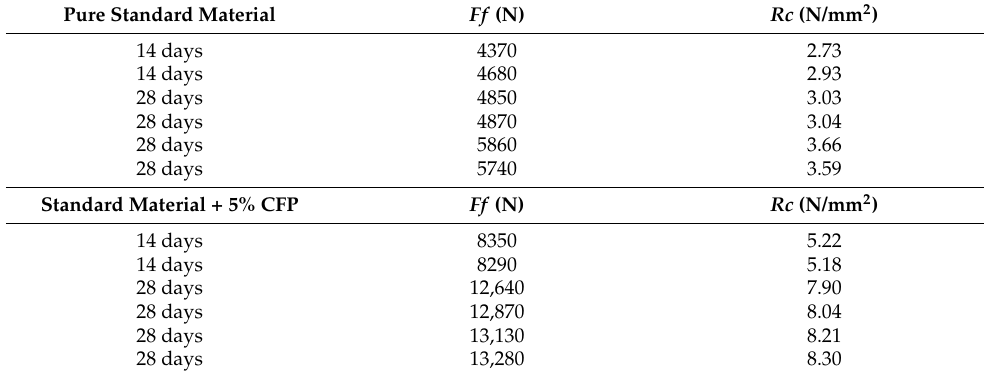
Figure 2. ( a ) Uniaxial ( Rc ), ( b ) flexural compressive ( Rf ) strength tests and ( c ) thermal conductivity tests on the standard and doped (ST with 5% of CFP) bentonitic grout samples. Table 2. Compressive strengths ( Rc ) at the fracture point obtained on the standard pure material and doped bentonitic grout (ST with 5% of CFP). Ff is the strength applied at the center of prismatic samples. Pure Standard Material Ff (N) Rc (N/mm 2 ) 14 days